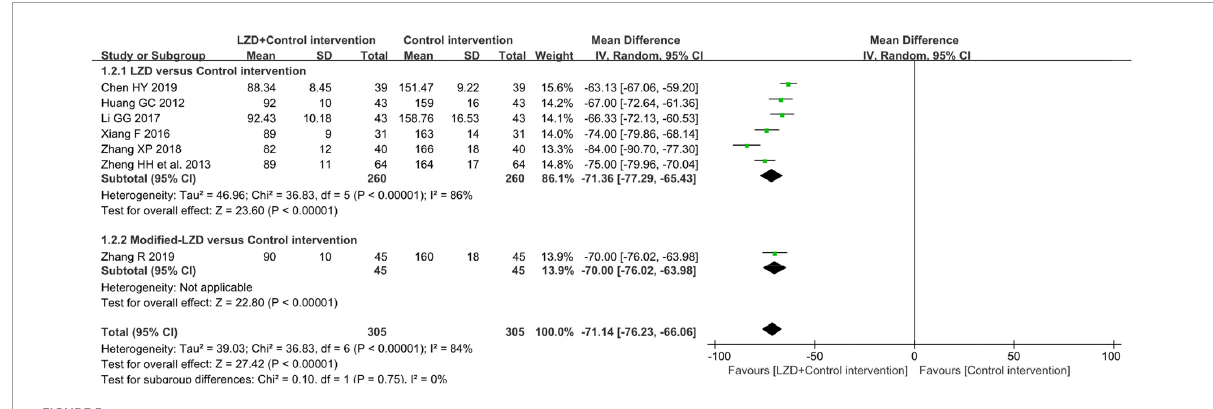
FIGURE5 Forest plot of the between-group for the comparison of the times of premature junctional beats in 24 h after treatment.